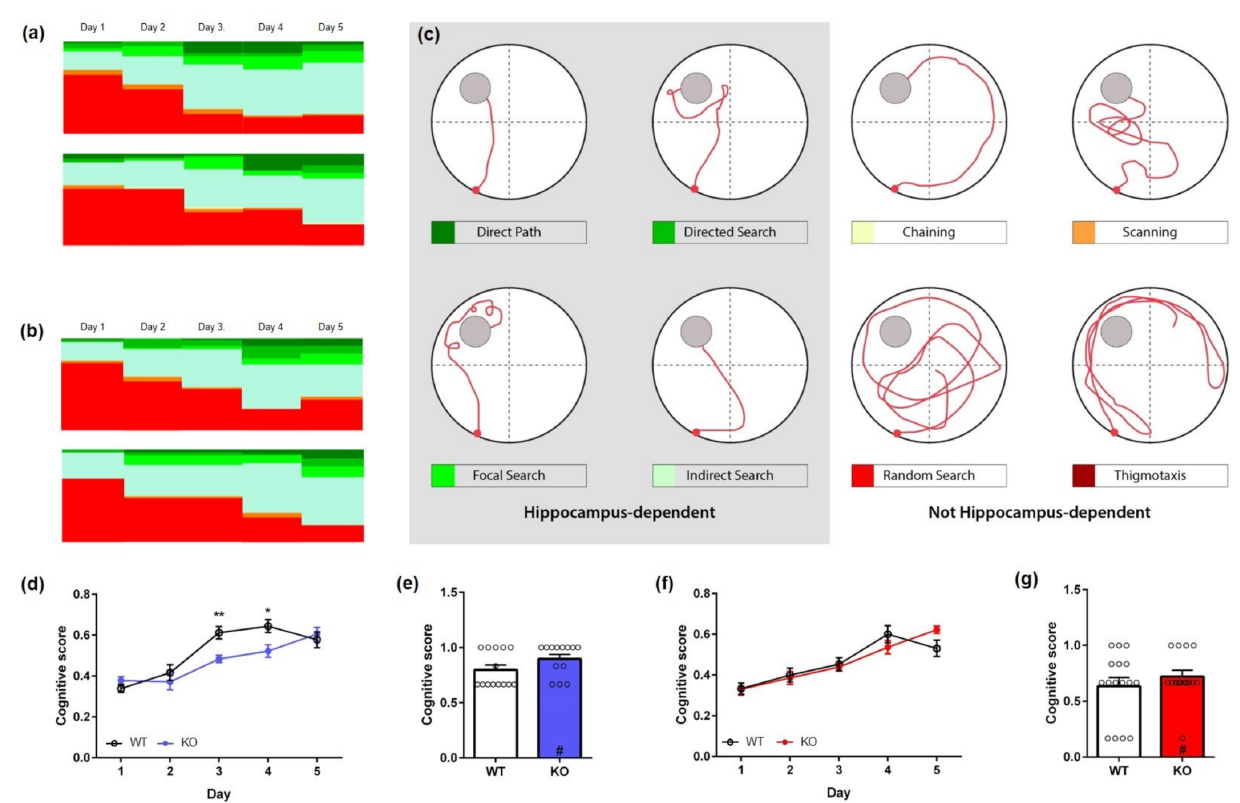
Figure 4. Qualitative analysis of spatial learning of Mover KO mice in the Morris water maze. Distribution of search strategies used by female ( a ) and male ( b ) KO Mover and same-sex WT mice. Animals showed a clear progression towards increasing spatial strategies over the 5 days of acquisition training. ( c ) Search strategies used by mice to locate the hidden platform in the MWM can be divided into hippocampus-dependent and non-hippocampus-dependent strategies. During the acquisition training, the cognitive scores of male ( d ) KO mice were significantly lower than those of WT animals. In contrast, cognitive scores did not differ between female KO and WT mice ( f ). During the probe trial, male ( e ) and female ( g ) KO mice showed a similar cognitive score compared to WT mice. Two-way repeated measures analysis of variance (ANOVA) followed by Bonferroni multiple comparisons ( d , f ) ANOVA and unpaired t -test ( e , g ); n = 13–15. Data presented as mean ± S.E.M. ANOVA: * p < 0.05, ** p < 0.01 (genotype difference); # p < 0.05 (sex difference).